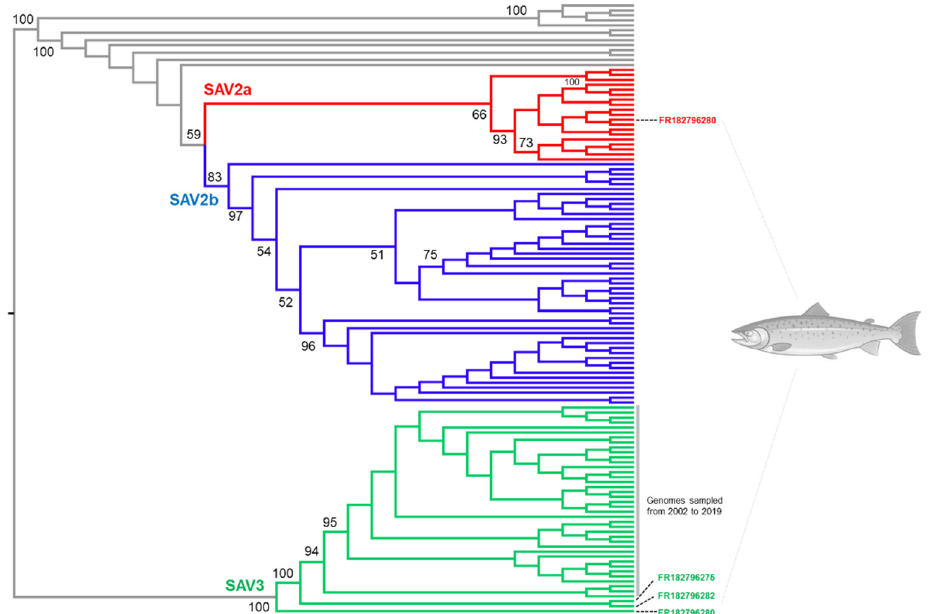
Figure 7. Maximum likelihood phylogeny reconstructing the evolution of SAV2 and SAV3 in Norwegian aquaculture, characterizing the phylogenetic position of the novel SAV3 genomes sequenced in this study (Table S1). The other included sequences represent 39 SAV3 genomes available on NCBI (Table S3) and the 81 SAV2 sequences used elsewhere in this study (Tables S1 and S2, i.e., Figures 3–5). The tree was generated using IQTREE [52] with the best-fitting nucleotide model (TIM2+F+G4). An ultrafast bootstrapping algorithm [53] was used to generate node support values (maximum value: 100). The sequence alignment is provided in the Supplementary Dataset S2.